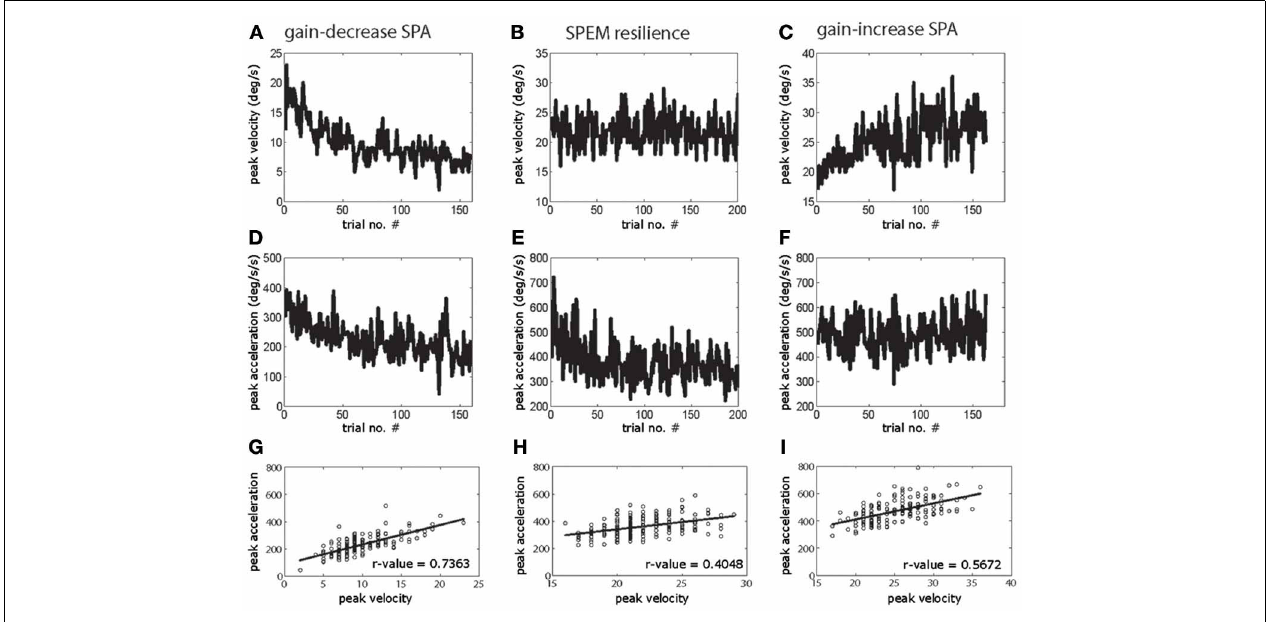
FIGURE 1 | Exemplary sessions of gain-decrease SPA (left column), SPEM resilience (middle column) and gain-increase SPA (right column). The upper row shows the changes in peak eye velocity (A–C) during the